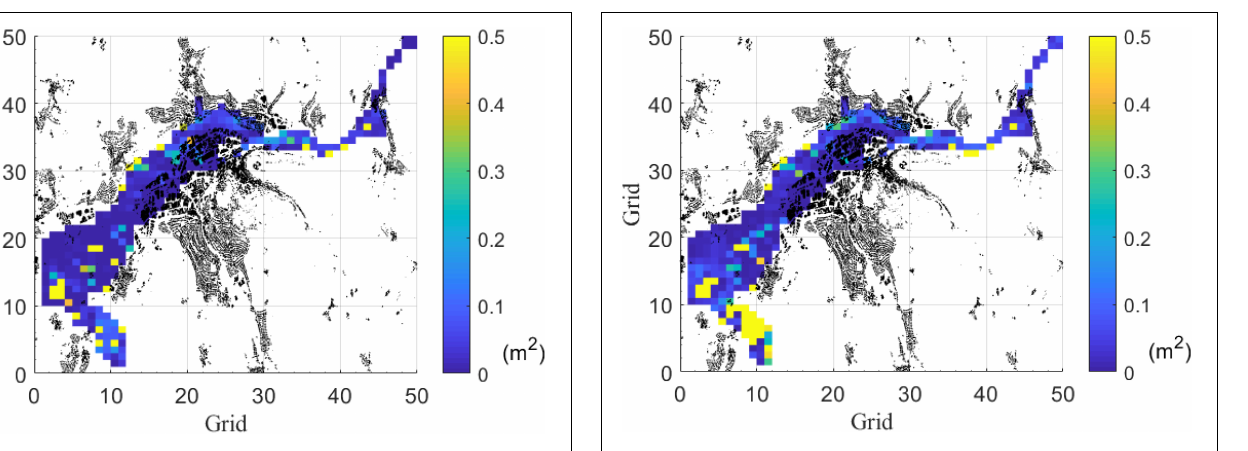
FIGURE 11 | Average MSE difference between the ANN and the hydrodynamic model of the historical event in May 2013. Black parts are houses. Each grid is an